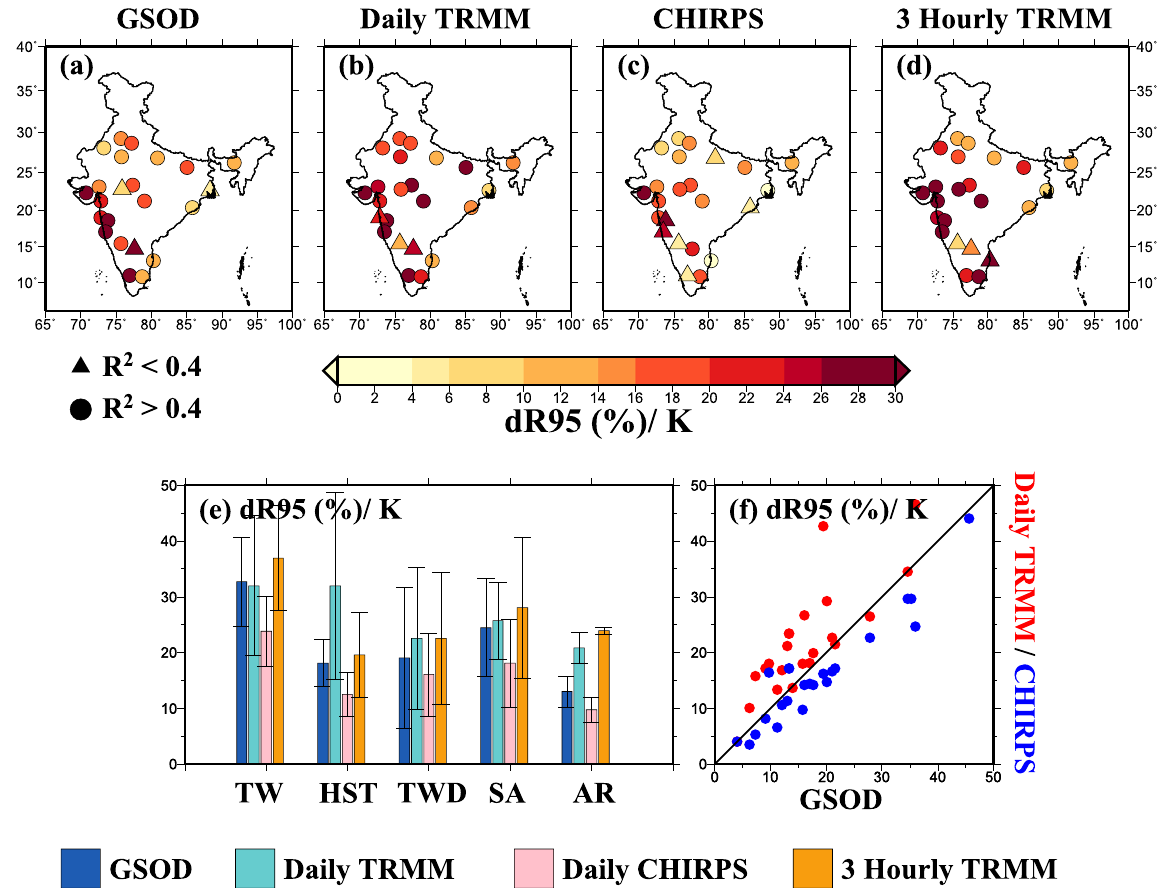
Figure 3. ( a – d ) Regression slopes (dR95/K, %) obtained from daily GSOD, daily TRMM, daily CHIRPS and 3-hourly TRMM data, respectively with dewpoint temperature (DPT) using quantile regression (QR) at the 95th percentile for 23 urban areas across India, ( e ) regression slopes (dR95/K) from daily GSOD (blue), daily TRMM (cyan), daily CHIRPS (pink) and 3-hourly TRMM (orange) data for different climatic zones respectively where bars denote mean values and whiskers show standard deviations, ( f ) agreement in scaling results between GSOD and Daily TRMM (red) and GSOD and CHIRPS (blue), pooled for all 23 urban areas. The figure was developed using the Generic Mapping Tools (GMT,